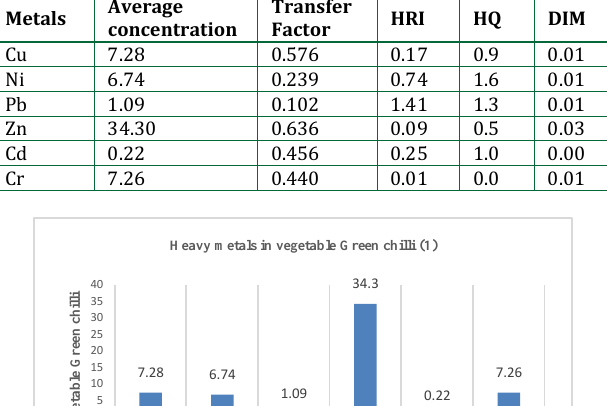
Table 13: Heavy metal Concentration in Vegetable Green Chilli (1).